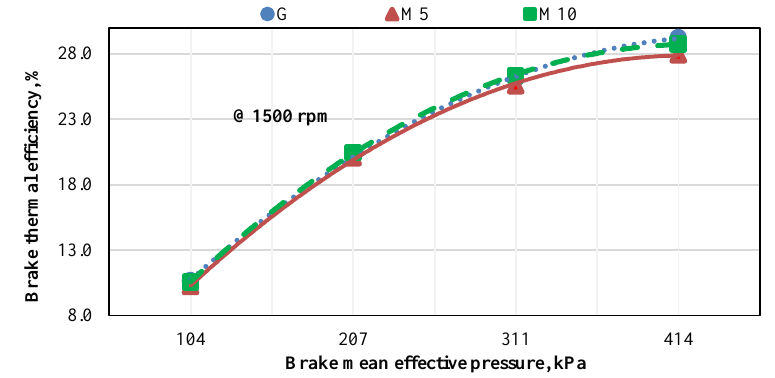
Fig. 5. Brake thermal efficiency of the engine for tested fuels at different